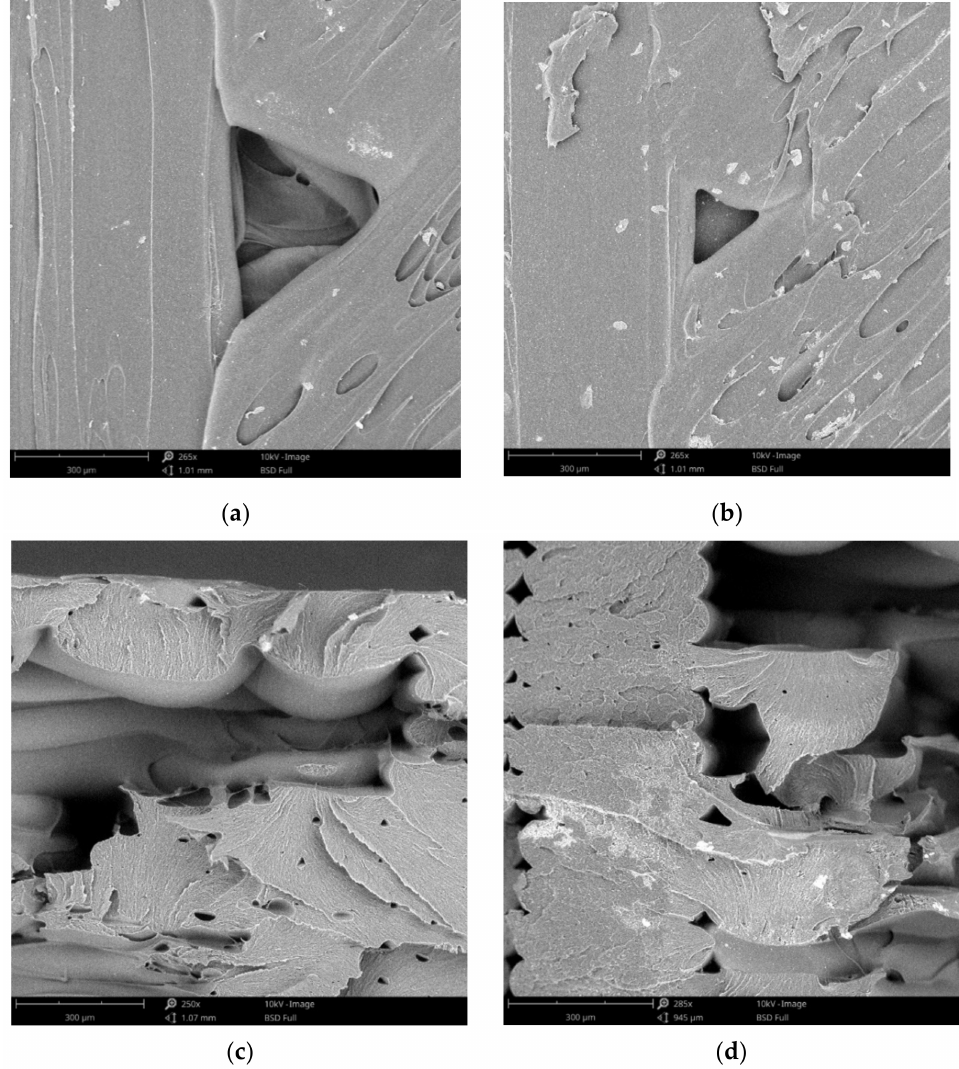
Figure 9. SEM images of disinfected ( a , c ) and control specimens ( b , d ) ( a , b —top view; c , d — fracture